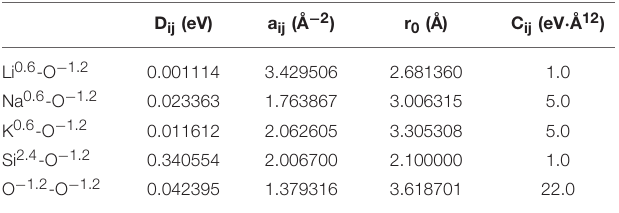
TABLE 1 | Interatomic potential parameters used in binary silicates from Pedone et al., 2006.